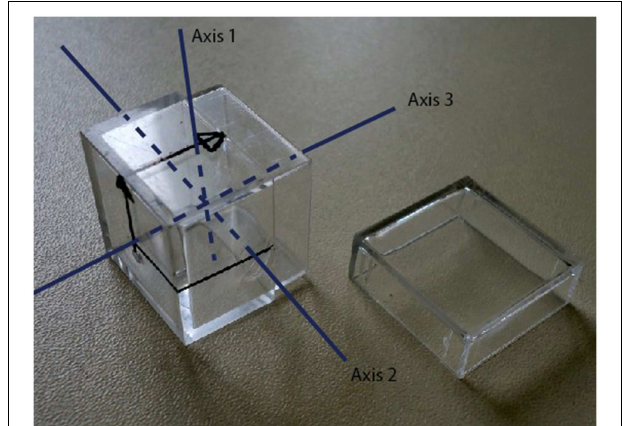
FIGURE 2 | AMS sampling box.